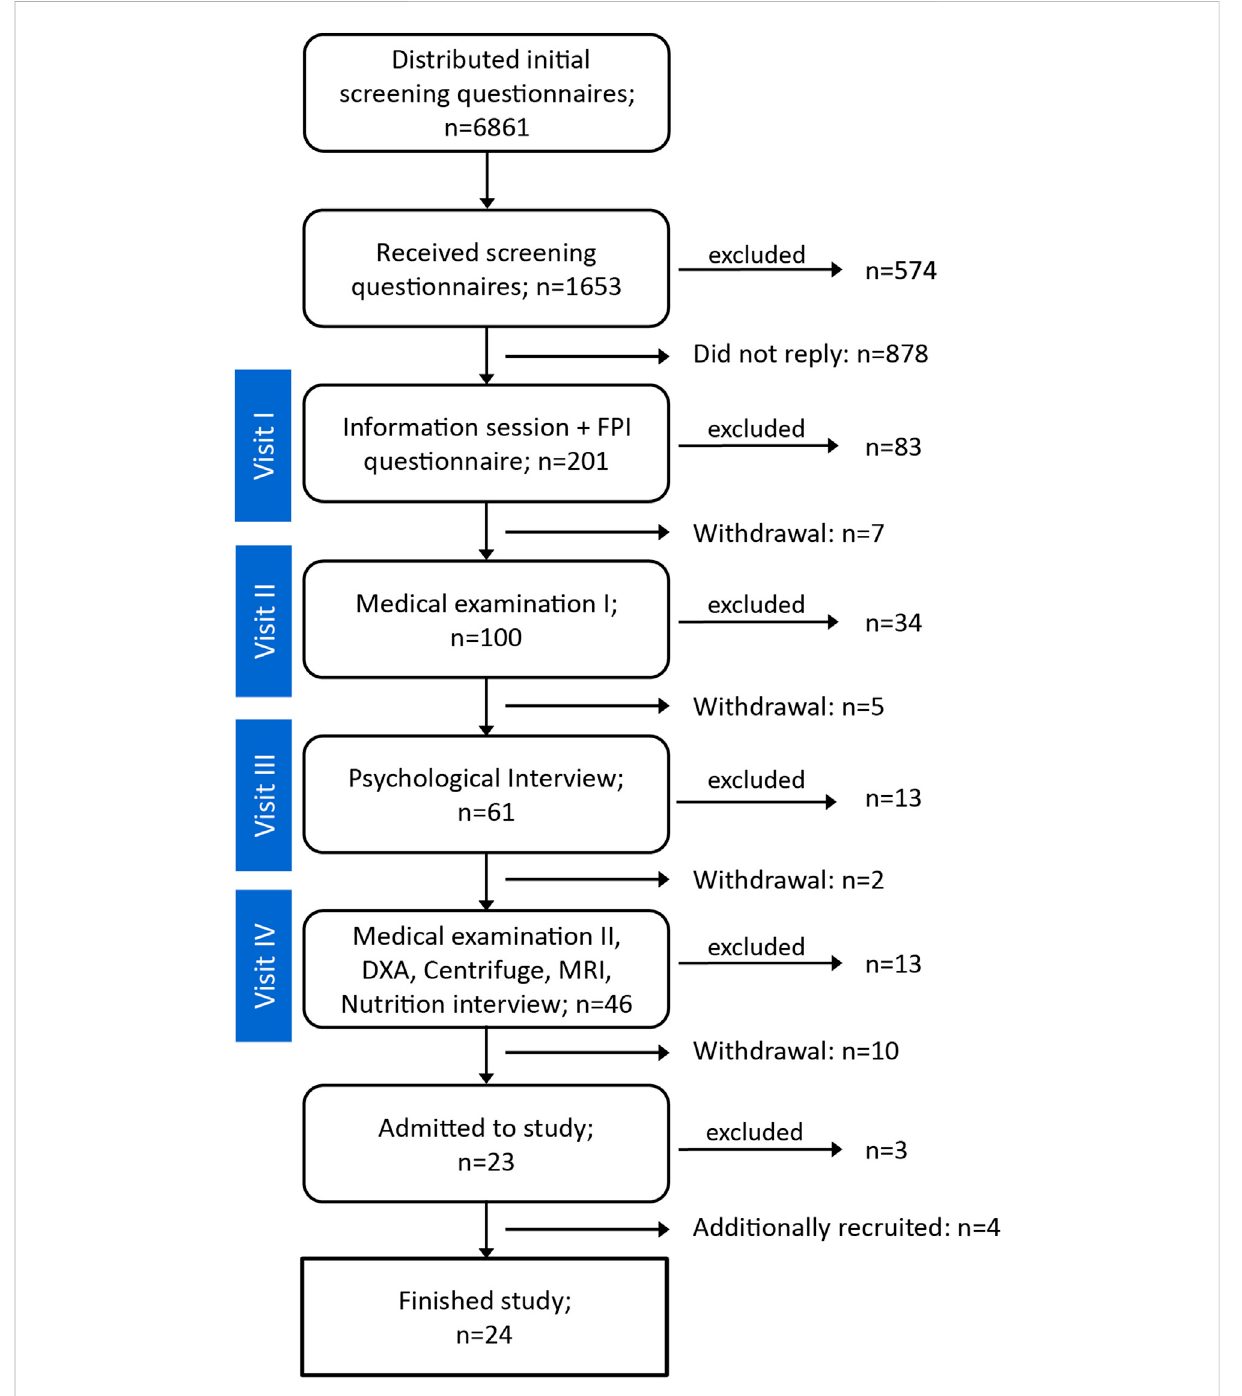
FIGURE 2 Number of candidates during the various steps of the selection